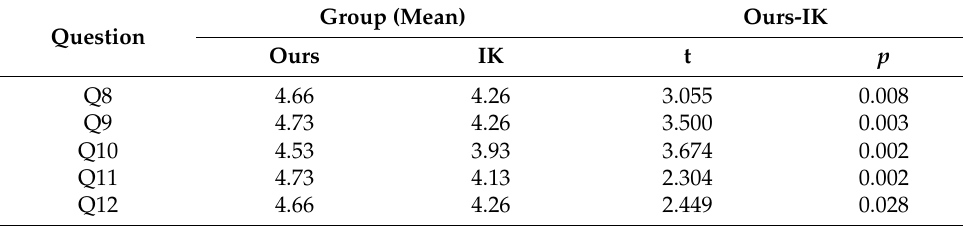
of questionnaire of the archery game under our method and the IK Table 9. Statistical analysis method . * marks the questions with insignificant